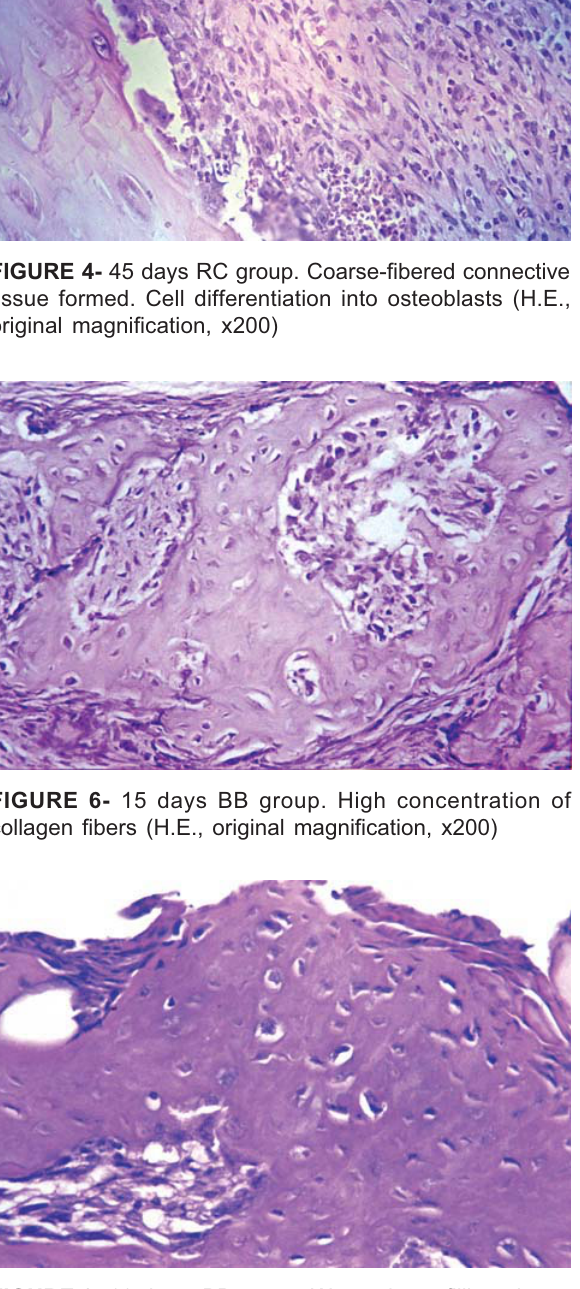
FIGURE 8- 60 days, BB group. Woven bone filling almost the whole defect (H.E., original magnification,